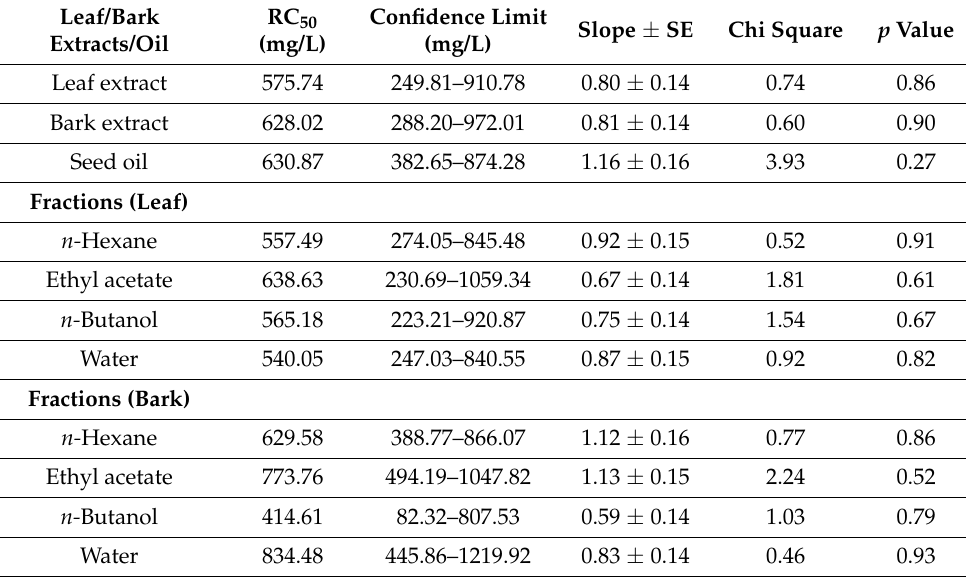
Table 5. Repellent activity of leaf/bark extracts, fractions, and seed oil of Triadica sebifera against Plutella xylostella .